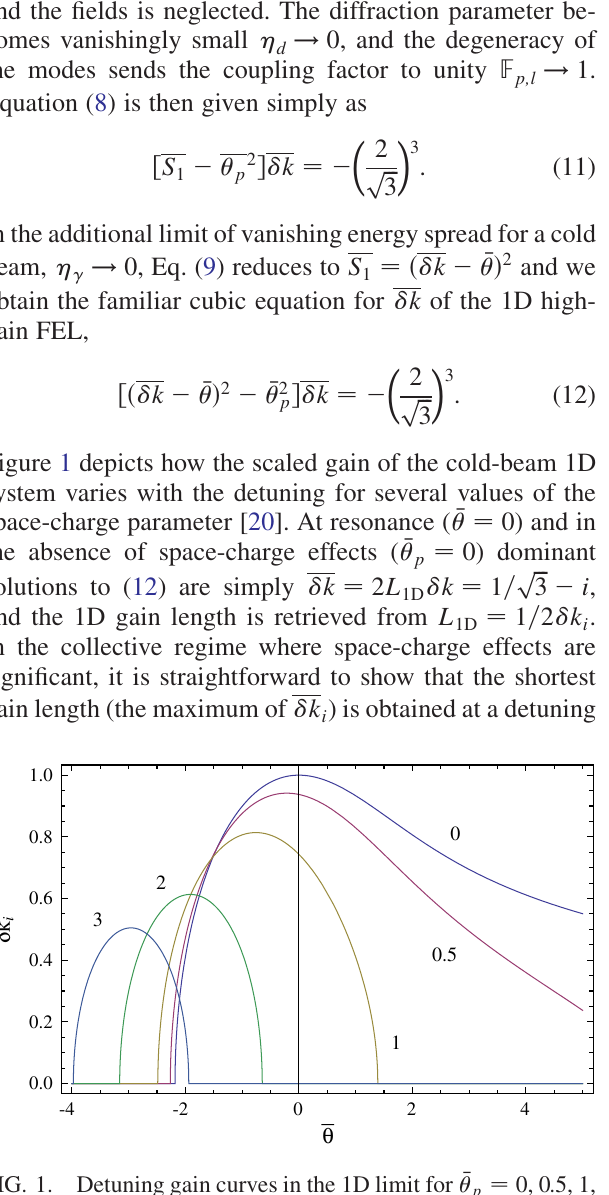
FIG. 1. Detuning gain curves in the 1D limit for 2, and